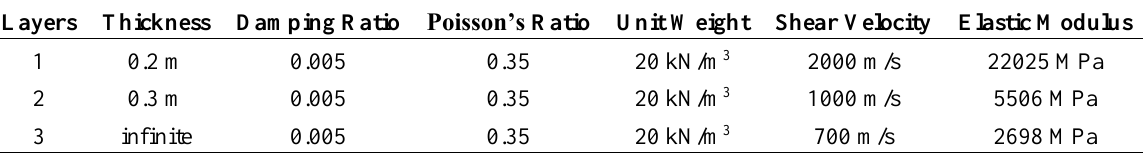
Table 2. Layered structure with descending velocity profile.